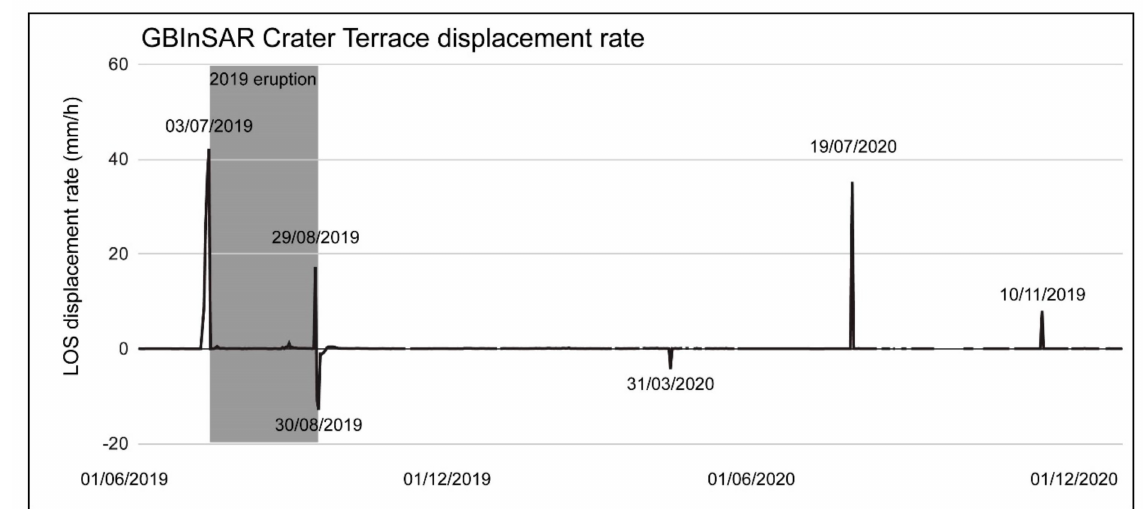
Figure 21. GBInSAR time series, with the 2019 effusive eruption in grey. It can be noted that only 3 explosive events were associated with displacement rate increases toward the sensors (3 July 2019, 19 July 2020, 10 November 2020). The increase in displacement rate, first toward then moving away from the sensors, recorded between 29 August 2019 and 30 August 2019 is associated with a more intense lava flow at the end of the 2019 eruption (inflation-deflation cycle). The signal with displacement rate increases away from the sensor recorded on 31 March 2020 was associated with overflows from the summit craters